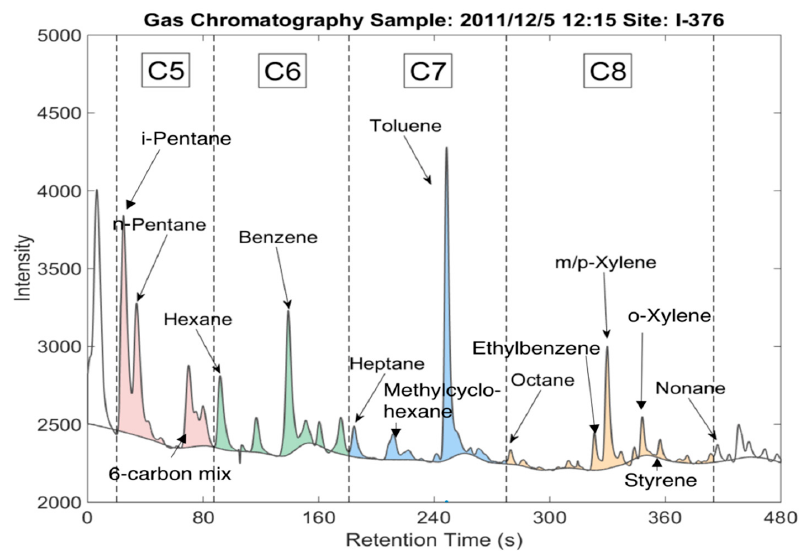
Figure 2. Example chromatogram. Speciated VOC compounds are marked at their peaks. Total VOC concentrations are calculated based on the area between the chromatogram signal and the fitted baseline, starting from i-pentane to everything before nonane.